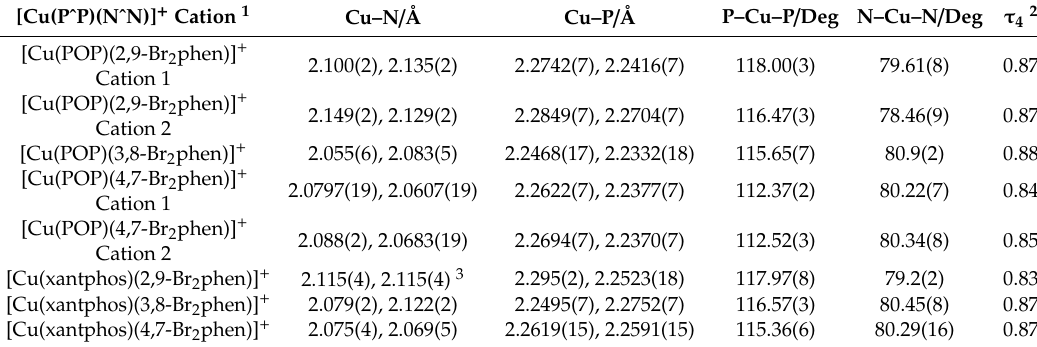
Figure 3. The structures of the cations in [Cu(xantphos)(3,8-Br 2 phen)][PF 6 ] · 1.1CH 2 Cl 2 · 0.7Et 2 O and [Cu(xantphos)(4,7-Br 2 phen)][PF 6 ] · CH 2 Cl 2 · 0.9Et 2 O with ellipsoids plotted at 40% probability level and H atoms omitted for clarity. ( a ) [Cu(xantphos)(3,8-Br 2 phen)] + and ( b ) [Cu(xantphos)(4,7-Br 2 phen)] + . Table 1. Comparison of the bond lengths and angles in the coordination spheres of the [Cu(PˆP)(NˆN)][PF 6 ]